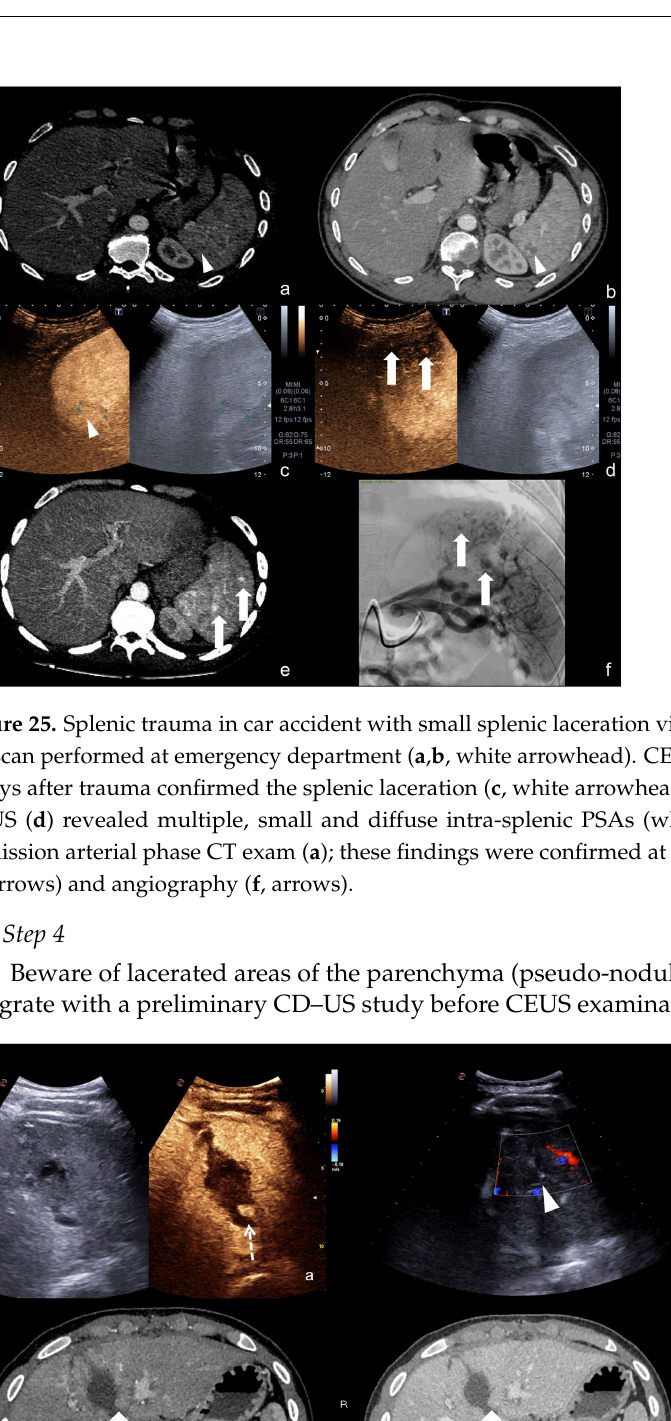
Figure 24. An example of multimodal visualization of post-traumatic splenic PSA (white arrows) at CD–US ( a ), CEUS ( b ), and arterial phase contrast-enhanced CT scan ( c ); CEUS follow-up examina- tion after embolization (d) showed no evidence of residual PSA.